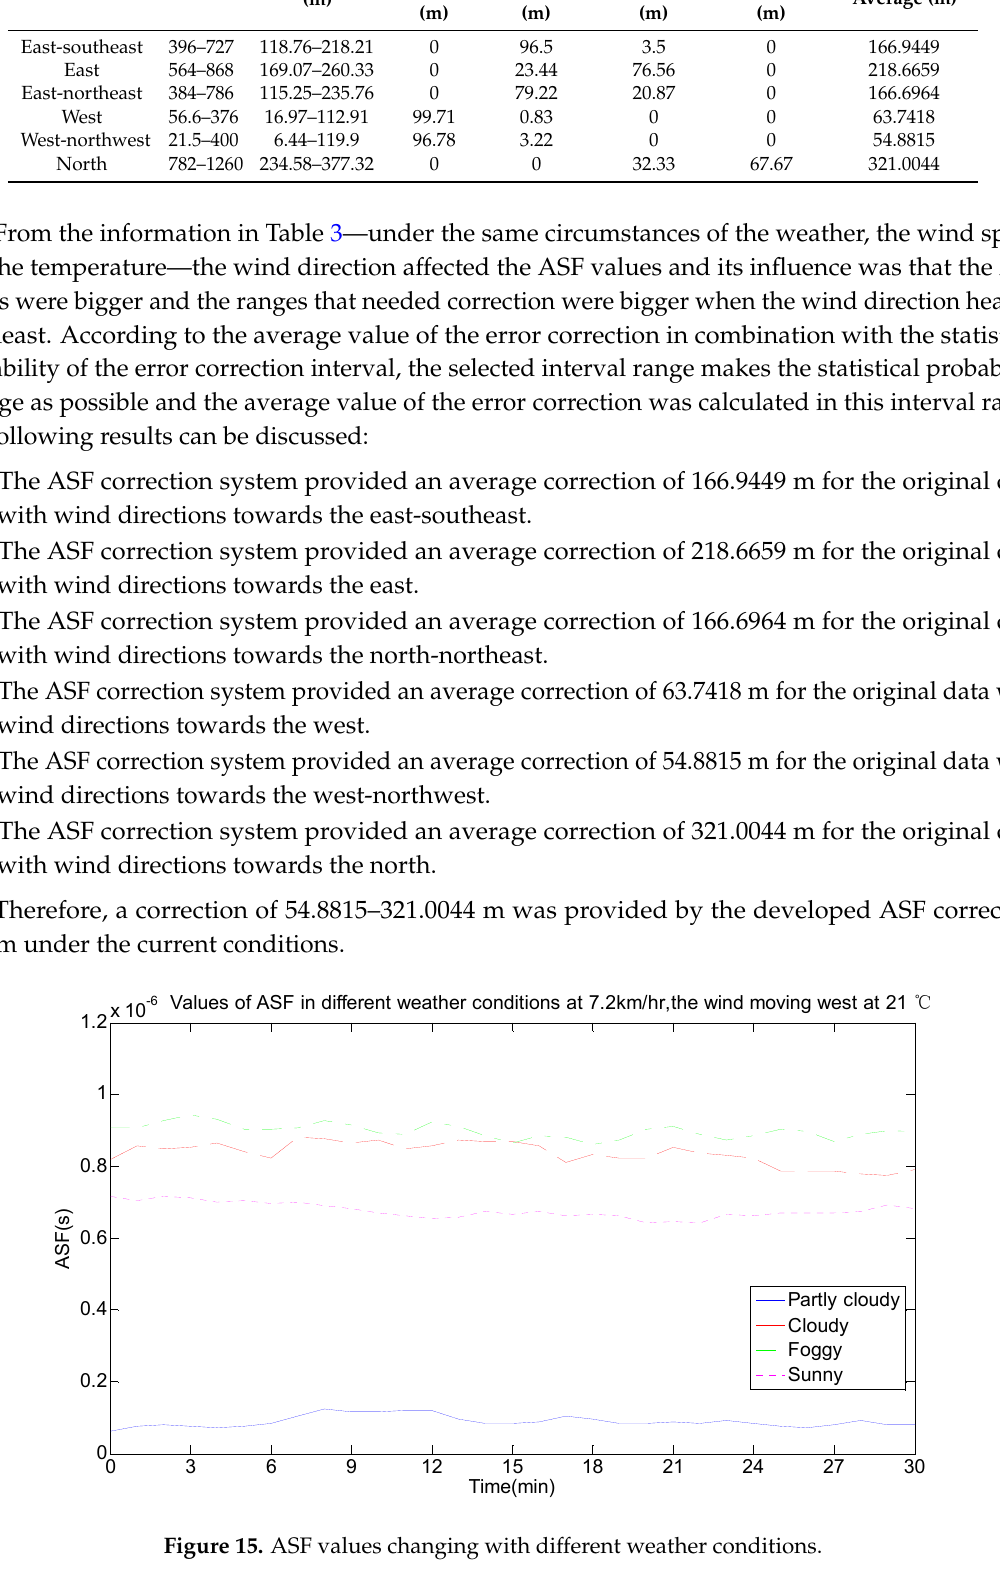
Table 3. The corresponding data change table of Figure 14.